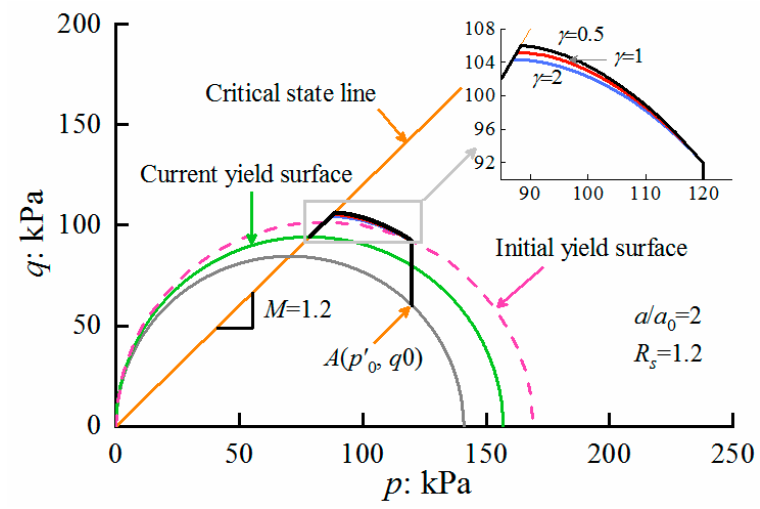
Figure 15. Effects of structural parameter γ on the effective stress paths.